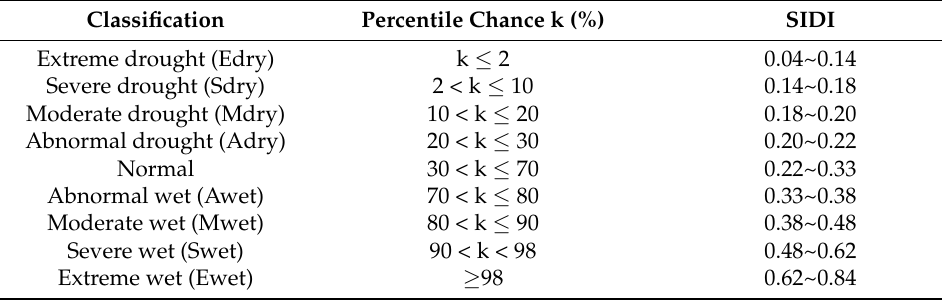
Table 2. Dry and wet classifications for the SIDI.